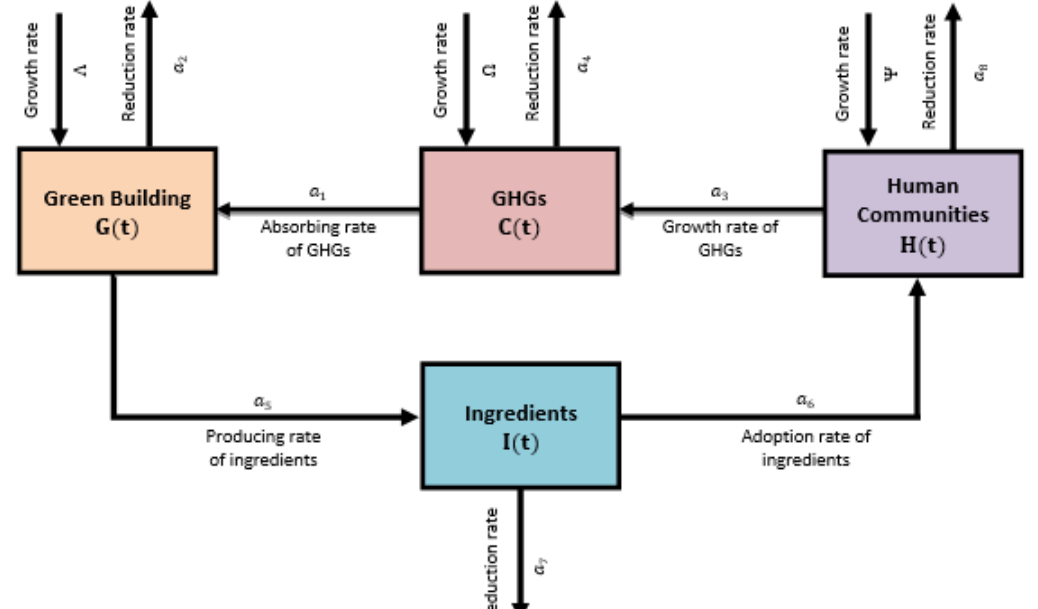
Figure 4. The schematic diagram describing the effect of green buildings on GHGs, ingredients, and human